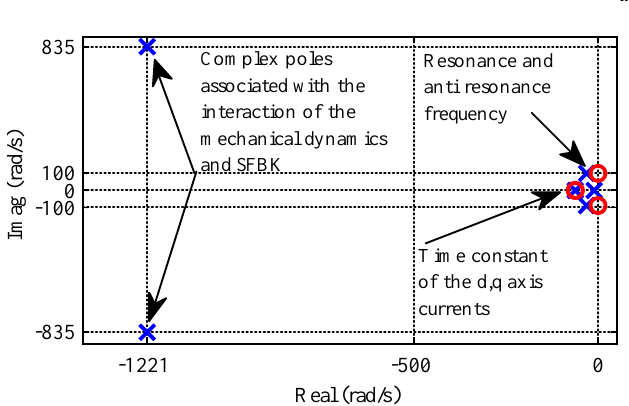
Figure 8. Poles and zeros distribution for